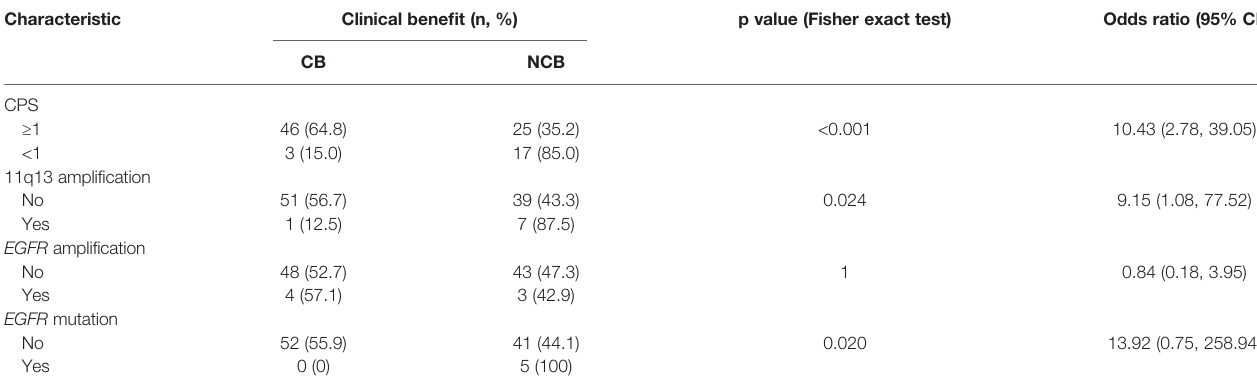
TABLE 2 | Logistic analysis of factors that affect clinical bene fi t.